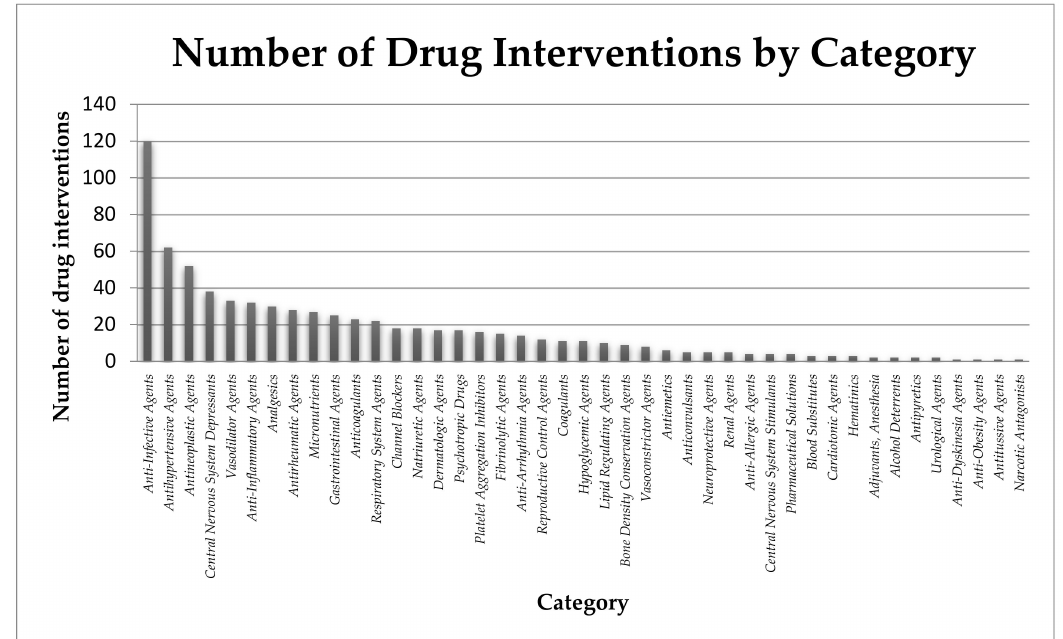
Figure 3. Potential drugs involved in clinical trials against COVID-19 classified in individual categories